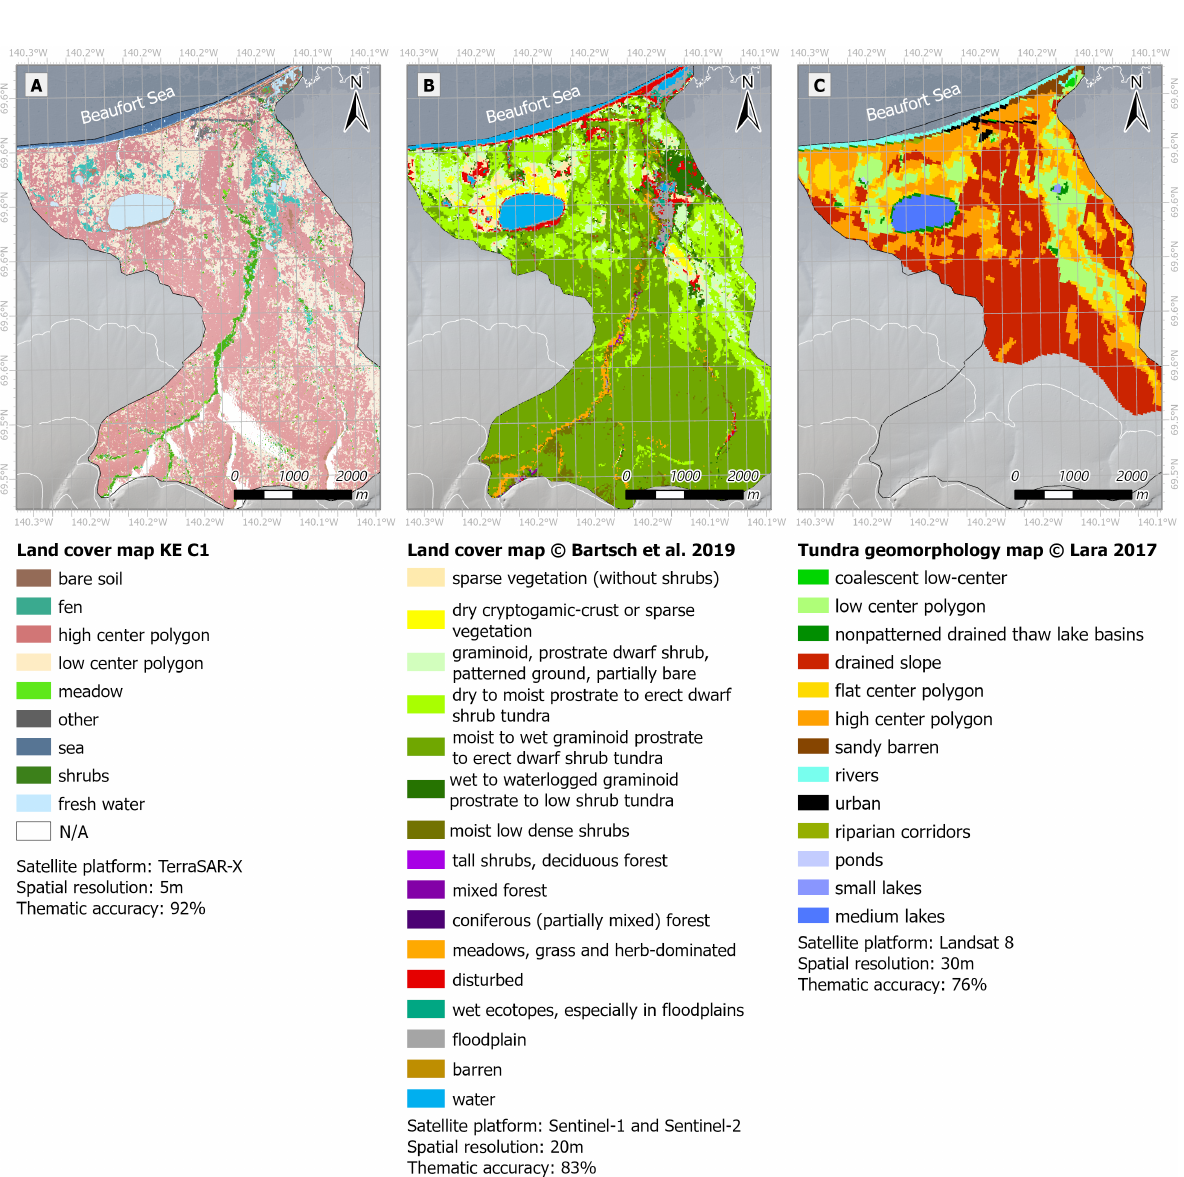
Figure 10. Comparison of land cover products available for the Komakuk Beach study area. ( A ) Land cover map of this study based on the multi-temporal Kennaugh element classification scheme, KE C1. ( B ) Land cover map [41]. ( C ) Tundra geomorphology map [40]. DEM(s) courtesy of the Polar Geospatial Center